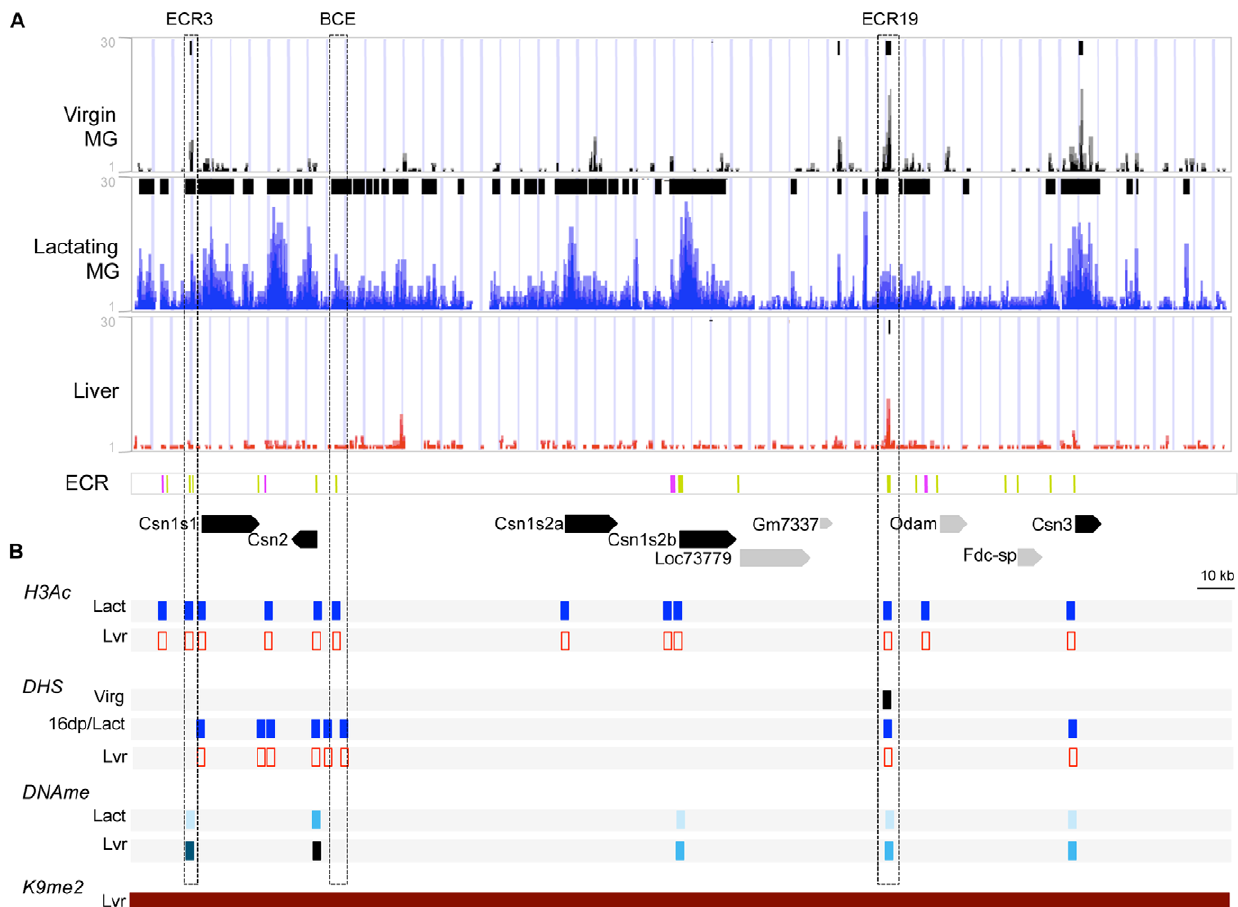
Figure 2. Chromatin markers in the casein gene cluster region in different tissues and developmental stages. This illustration is a close- up of the CSN region from Figure 1. ( A ) ChIP-seq reads for H3K4me2 in MEC isolated from virgin mammary glands at 12 weeks of age, staged at diestrus ( Virgin MG , black), in lactating mammary glands ( Lactating MG , blue) and in liver tissue ( Liver , red). A summary of peaks identified by MAC and SICER are at the top of each of the Virgin MG, Lactating MG, and Liver panels. In the evolutionary conserved region ( ECR ) panel, ECRs are shown in green; ECR1, 6 16 and 21 are indicated in pink. In the bottom panel, the locations of the casein genes (black) and non-casein genes (gray) are indicated by solid arrows denoting the direction of transcription. ( B ) Summary of markers of epigenetic regulation in the CSN region. ( H3Ac ) Summary of results of ChIP for H3-acetylation on lactating mammary gland ( Lact , blue) and liver tissue ( Lvr , red). Sites investigated are indicated by rectangles: filled rectangles, H3AC enriched; open rectangle, non-enriched (See figure S3). ( DHS ) Summary of DNaseI Hypersensitivity analysis in MEC isolated from from virgin mammary glands at 12 weeks of age, staged at diestrus ( Virg , black), in lactating mammary gland ( Lact , blue) and liver tissue ( Lvr , red). Sites investigated are indicated by rectangles: filled rectangle, DHS; open rectangle, non-DHS (see Fig. S4). ( DNAme ) Summary of results of DNA methylation analysis on lactating mammary gland ( Lact ) and liver tissue ( Lvr ) (see also Fig. 5). Levels of DNA methylation are based on Fig. 5A and Table S2 and are color coded as follows: 0–20% lightest blue, 21–40% light blue, 41–60% blue, 61–80% dark blue and 80–100% black; open rectangles: not analyzed. ( K9me2 ) Summary of ChIP-chip for H3K9me2, a histone modification associated with closed chromatin, on liver tissue from [62]; red filled rectangle indicates enrichment of H3K9me2 in liver tissue. gland, levels of DNA methylation at casein gene promoters and ECRs are lower in the lactating mammary gland relative to the liver.